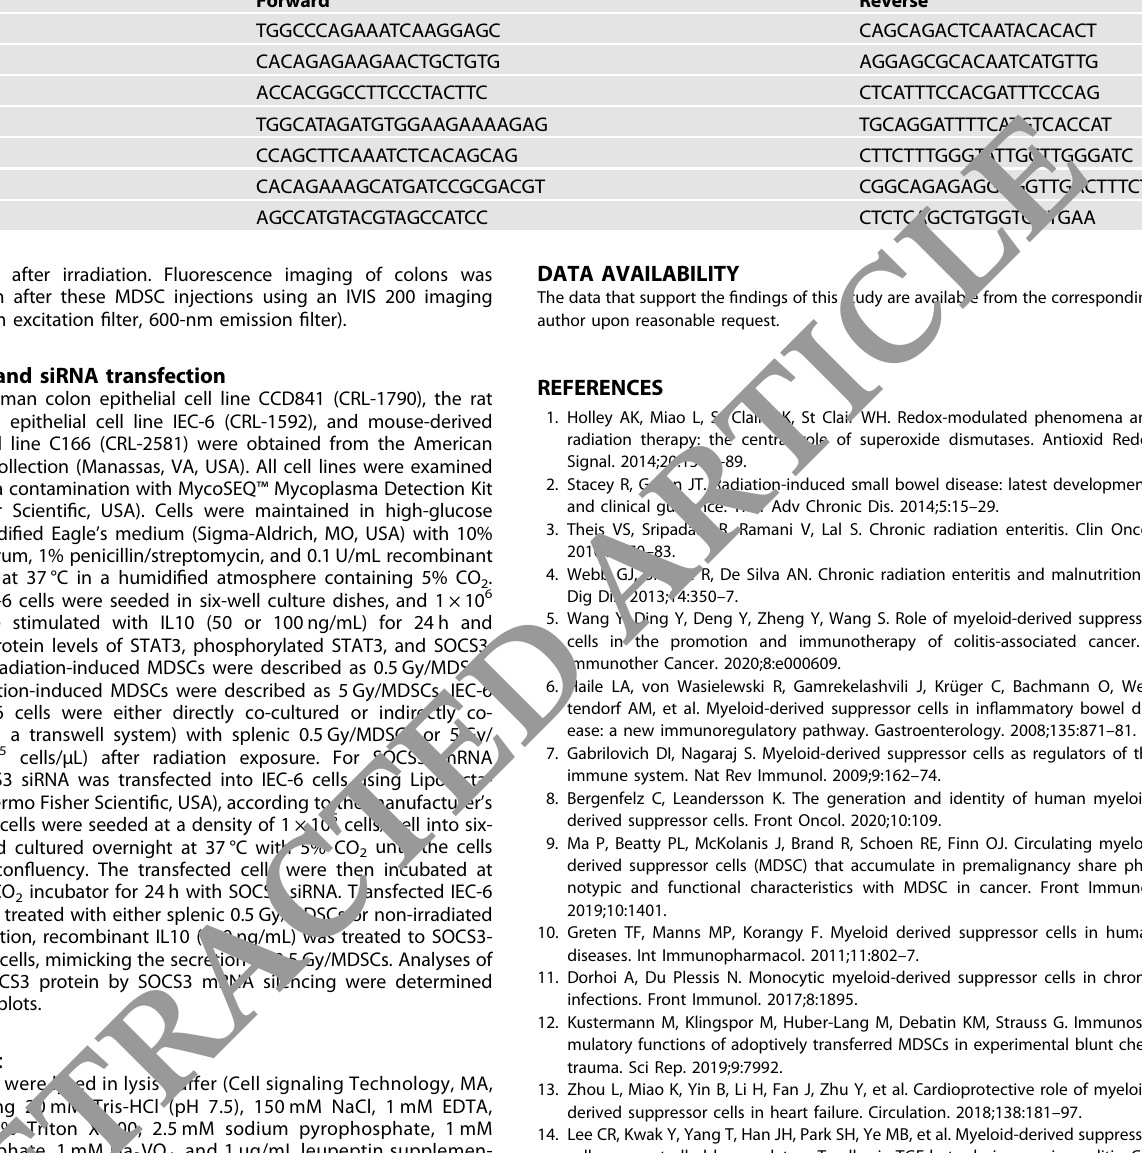
Table 1. Primers and sequences used for qRT-PCR. Mouse IL-10, TGF β , IL-6, IL-1 β , TNF- α , IFN- γ and β -actin primers for qRT-PCR are listed.